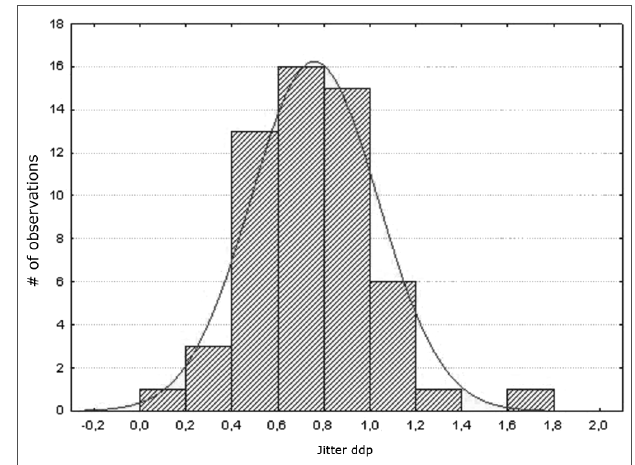
Figure 1. Normal distribution of the fundamental frequency - Histo- gram